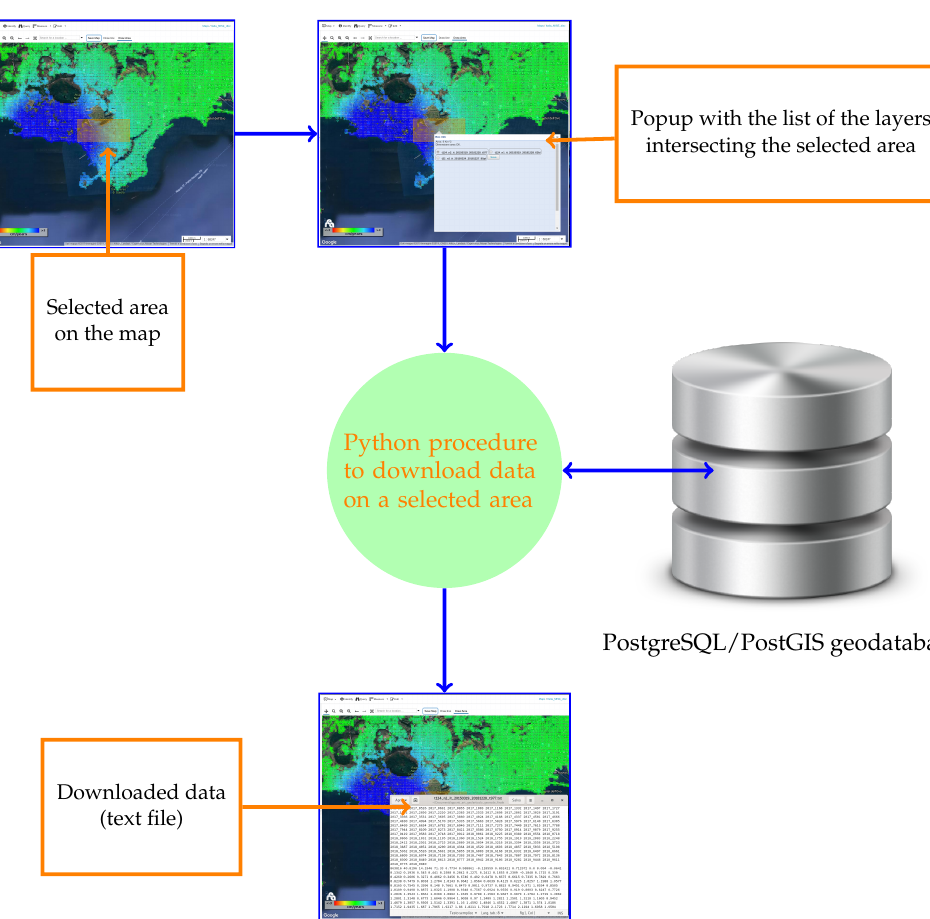
Figure 11. Flow chart of the procedure for download data on a selected area.